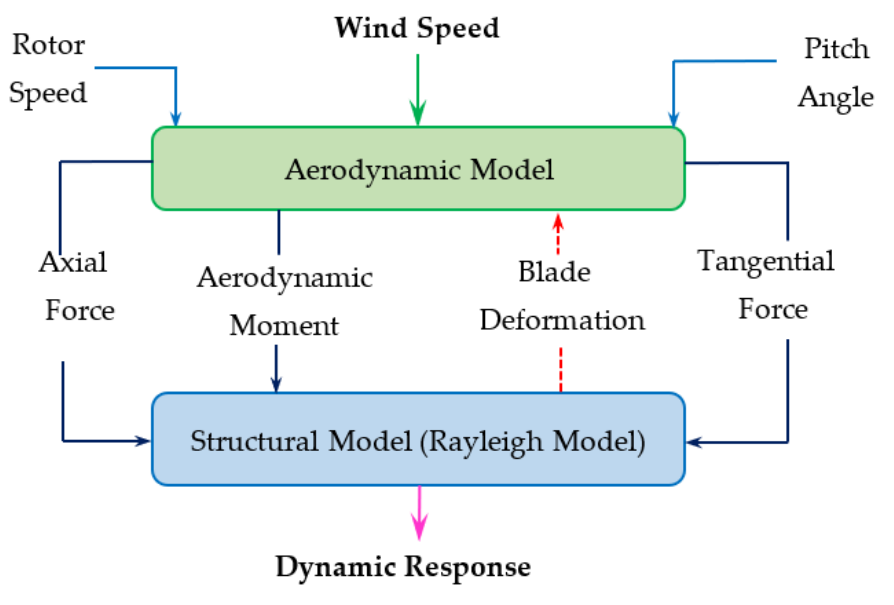
Figure 1. Structural wind turbine blade modeling.